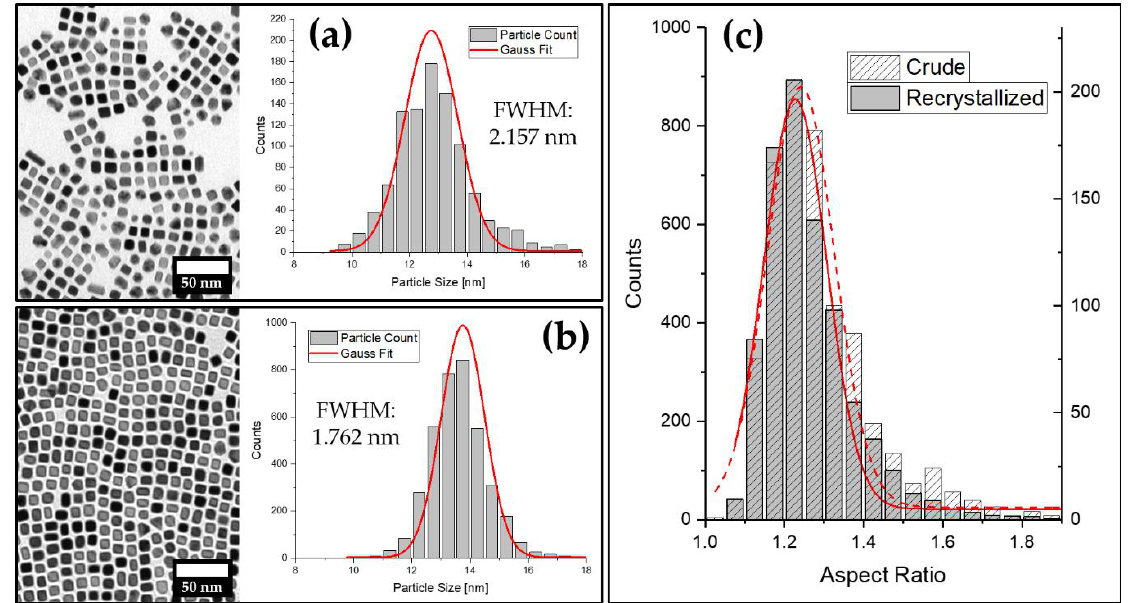
Figure 5. ( a ) TEM image of a crude batch of platinum nanocubes with the corresponding particle size distribution; ( b ) TEM image and corresponding particle size distribution of the same batch as shown in ( a ) after recrystallization from THF within 24 h; ( c ) comparison of particle aspect ratio distributions of both samples: crude ( a ) and recrystallized ( b ).